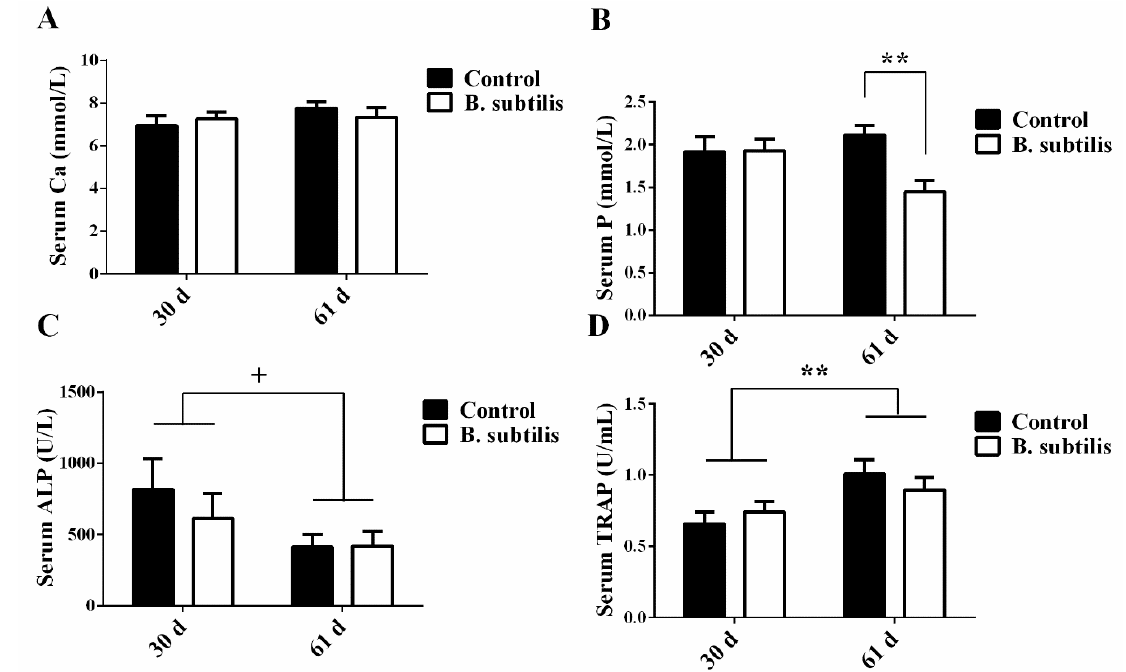
Figure 1. The effects of Bacillus subtilis and age on biochemical indicators of bone metabolism in laying hens. ( A ) Ca concentration in serum at day 30 and day 61. ( B ) P concentration in serum at day 30 and day 61. ( C ) ALP concentration in serum at day 30 and day 61. ( D ) TRAP concentration in serum at day 30 and day 61. Data are presented as mean ± SEM ( n = 12 per group) ** means p ≤ 0.01; and + means 0.05 < p < 0.1. ALP: alkaline phosphatase; Ca: calcium; P: phosphorus; TRAP: tartrate-resistant acid phosphatase.